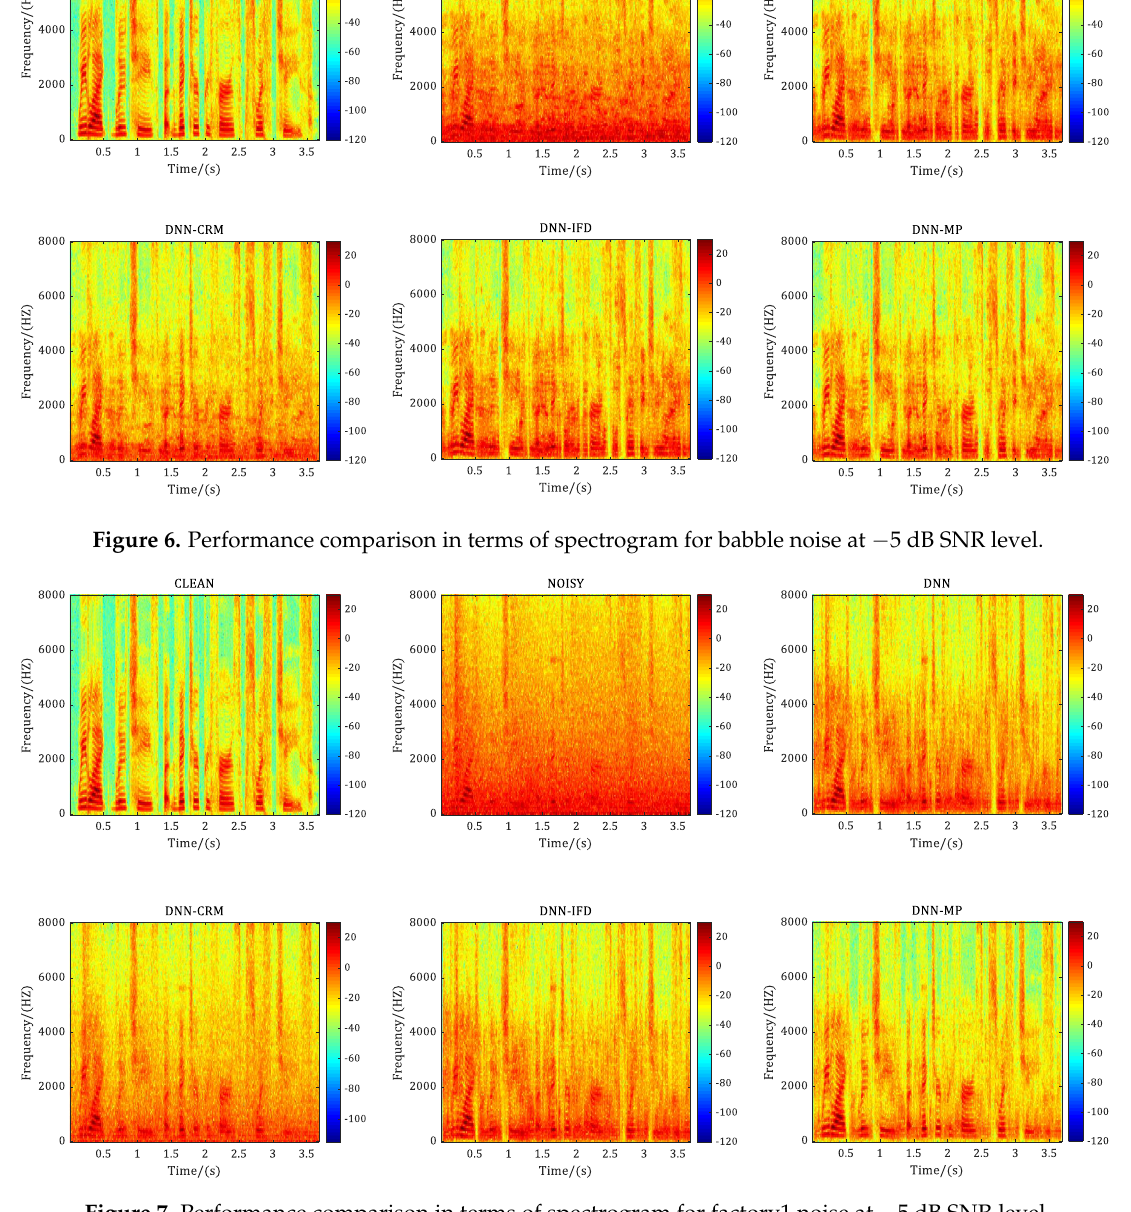
Figure 7. Performance comparison in terms of spectrogram for factory1 noise at − 5 dB SNR